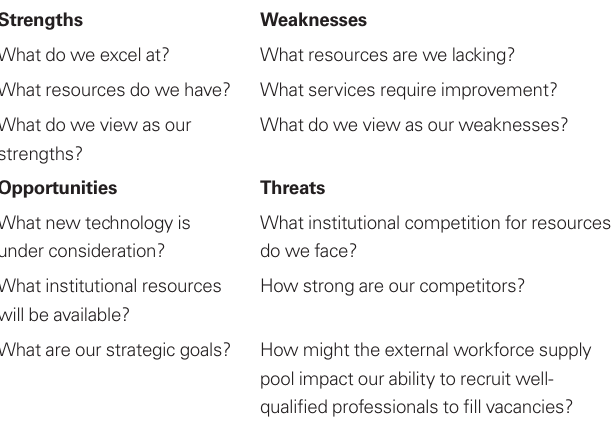
Table 2 | radiation oncology SWOT matrix